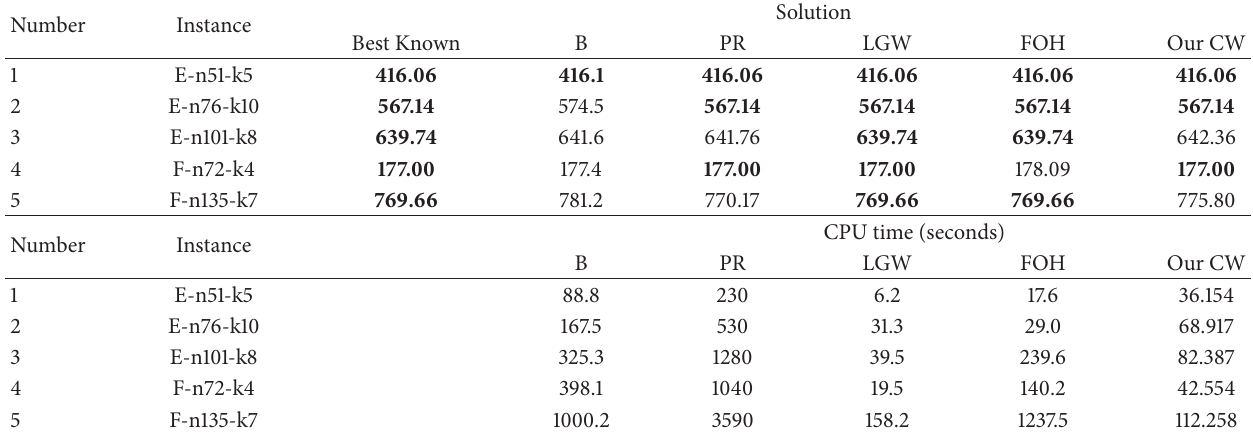
Table 5: Computational results between the proposed CW and the other algorithms for data sets E and